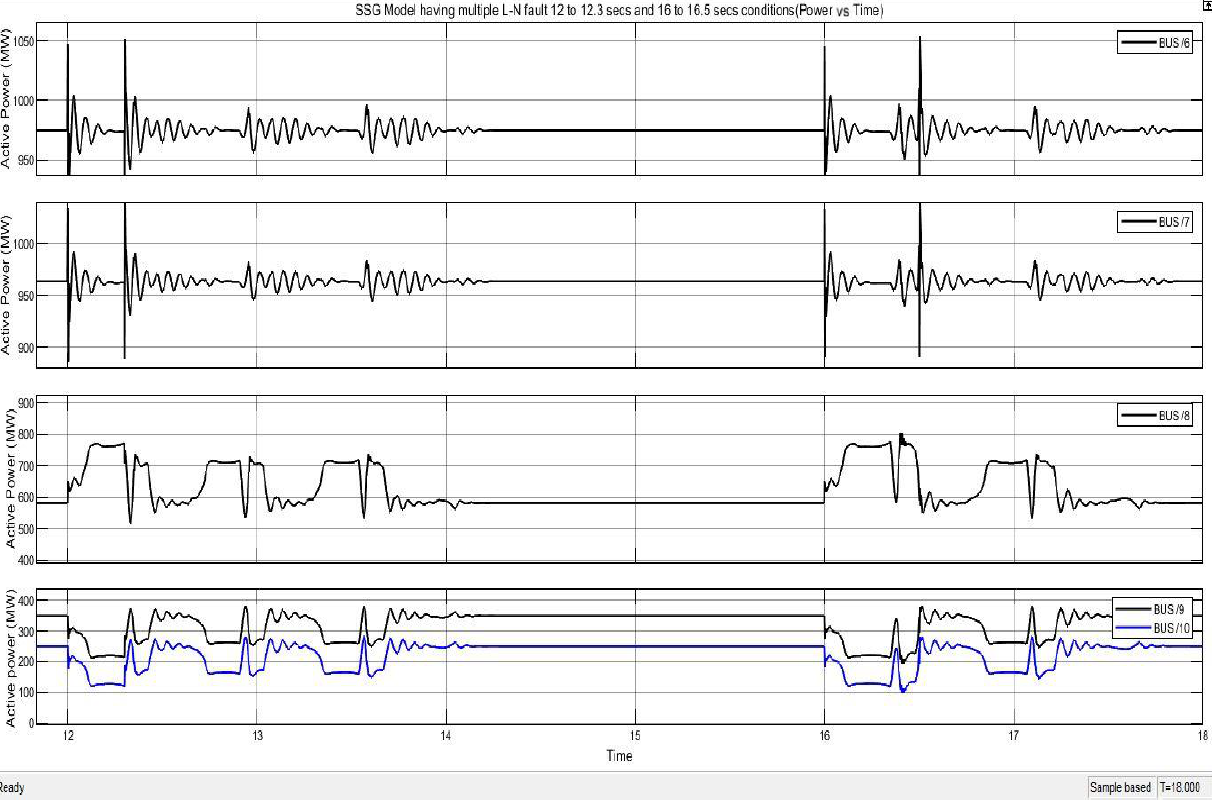
Figure 20. Multiple line-to-ground faults are inserted in the system from 12 to 12.3 s and 16 to 16.5 s (Bus 6 to Bus 10).